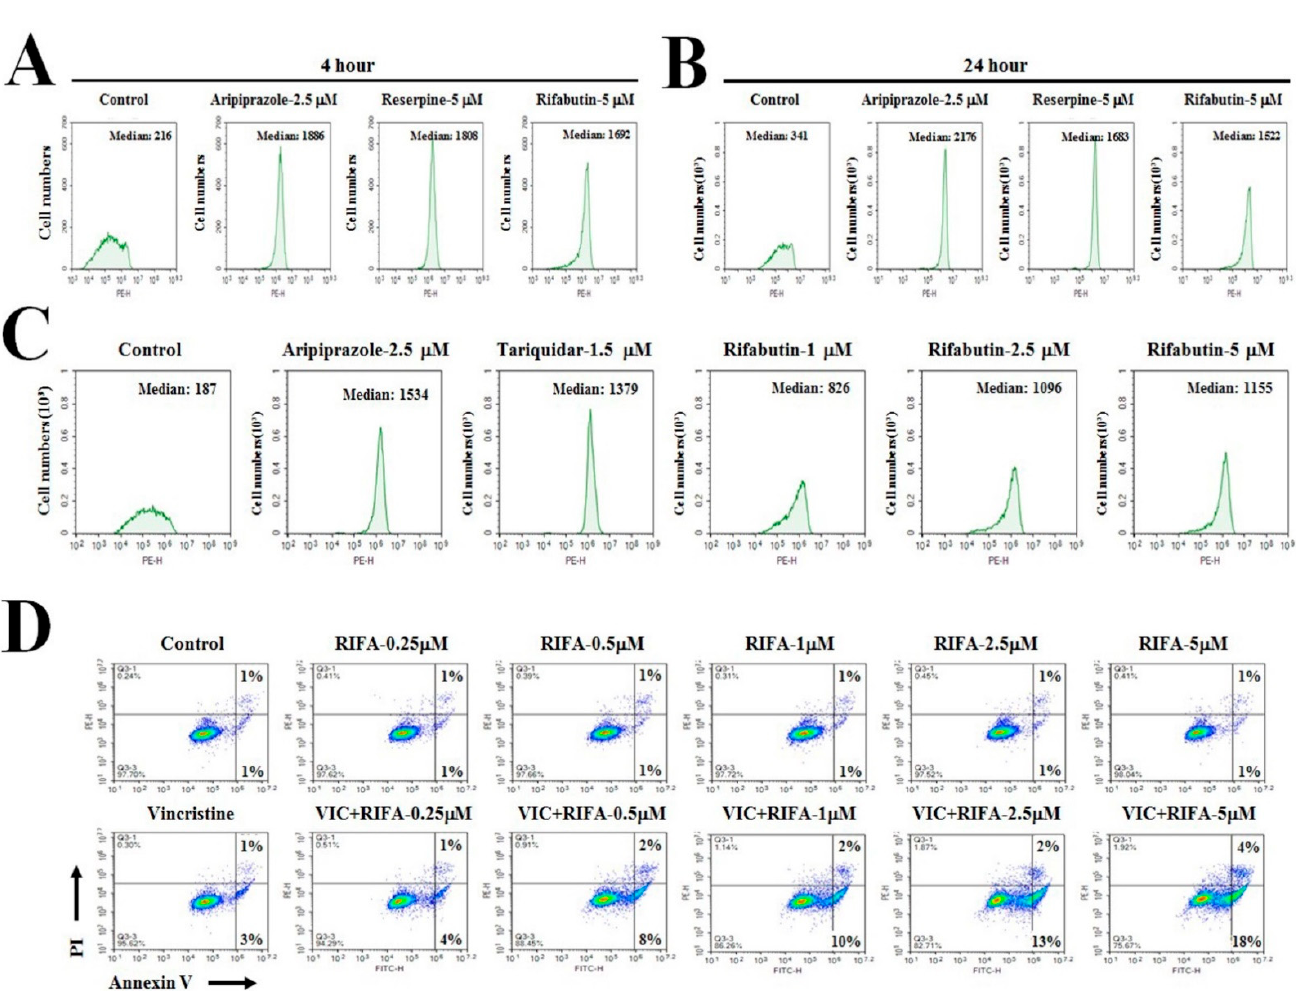
Figure 2. Rifabutin has high P-gp-inhibitory activity and increases early apoptosis in VIC-treated KBV20C cells. ( A – C ) KBV20C cells were treated with indicated concentrations of aripiprazole, reserpine, tariquidar, rifabutin (RIFA), or 0.1% DMSO (Control). After 4 h ( A ), 24 h ( B ), or 4 h ( C ) of rhodamine123 staining, all cells were examined using FACS analysis. ( D ) KBV20C cells were treated with 5 nM VIC, the indicated concentration ( μ M) of rifabutin (RIFA) alone, or in combination with 5 nM VIC, or 0.1% DMSO (Control). After 24 h, annexin V analyses were performed as described in Section 4: Materials and Methods.